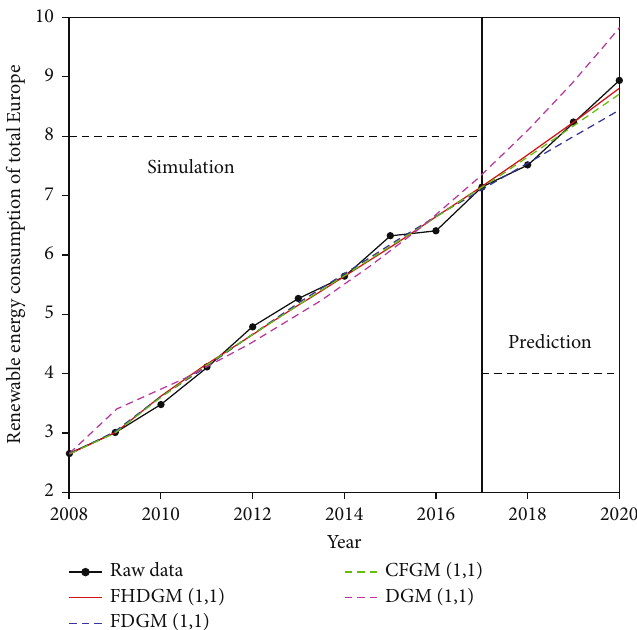
Figure 7: Fitted and predicted values of renewable energy consumption in all of Europe.